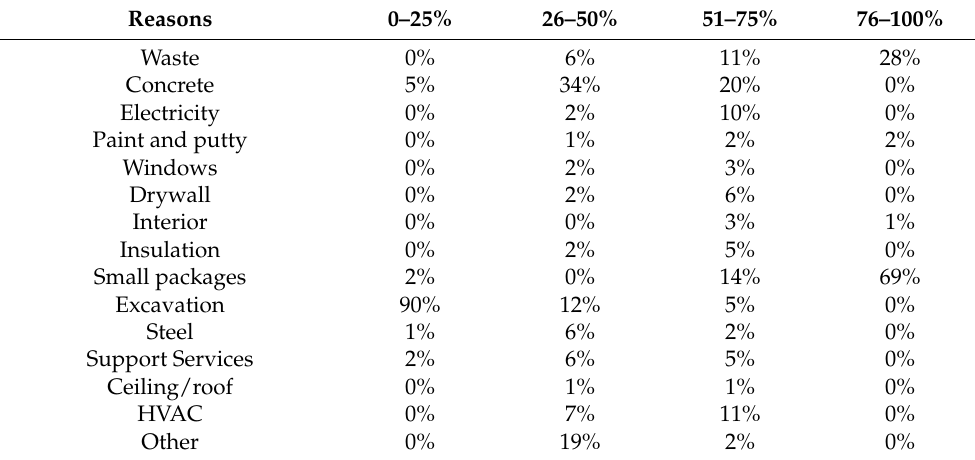
Table 5. Reasons for transports during different completion percentages of